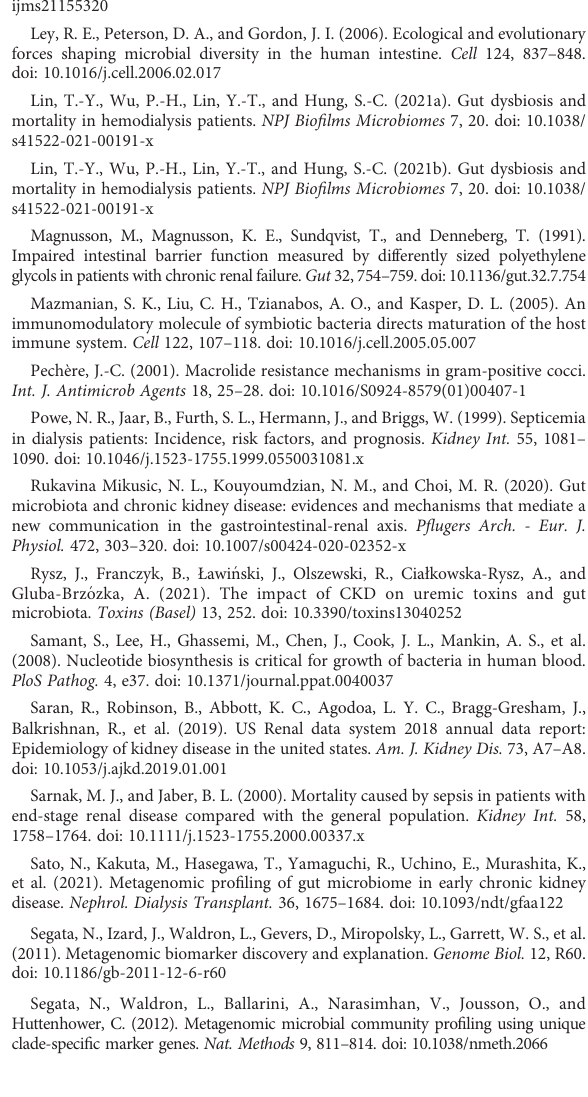
SUPPLEMENTARY FIGURE 1 Beta-diversity was not altered in different groups. (A) Unweighted UniFrac distance. (B) Weighted UniFrac distance. HC, healthy controls; HD, HD